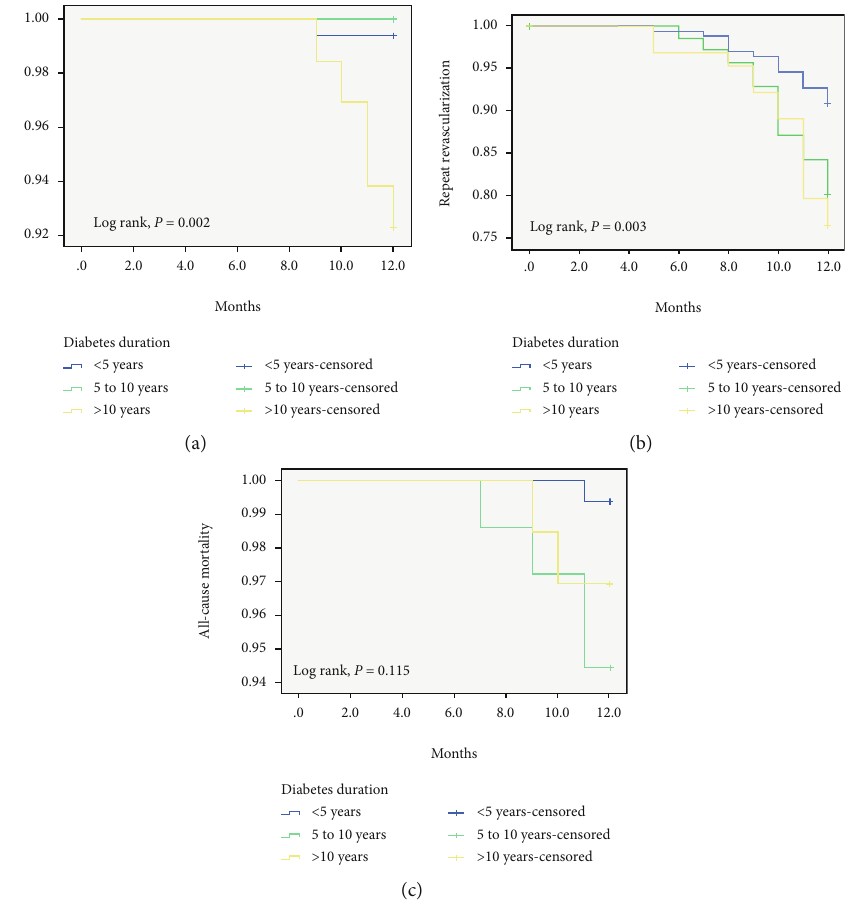
Figure 2: Kaplan-Meier survival curves for MACEs based on diabetes duration. (a) Patients with the most extended duration of diabetes have a signi fi cantly increased risk of myocardial infarction compared to those with shorter duration. (b) A signi fi cantly higher risk of repeat revascularization was observed in patients with longer duration of diabetes compared to those with shorter duration. (c) Diabetes duration was not signi fi cantly associated with an increased risk of all-cause mortality at 1 year. Table 4: Hazard ratios for MACEs based on diabetes duration. Number of